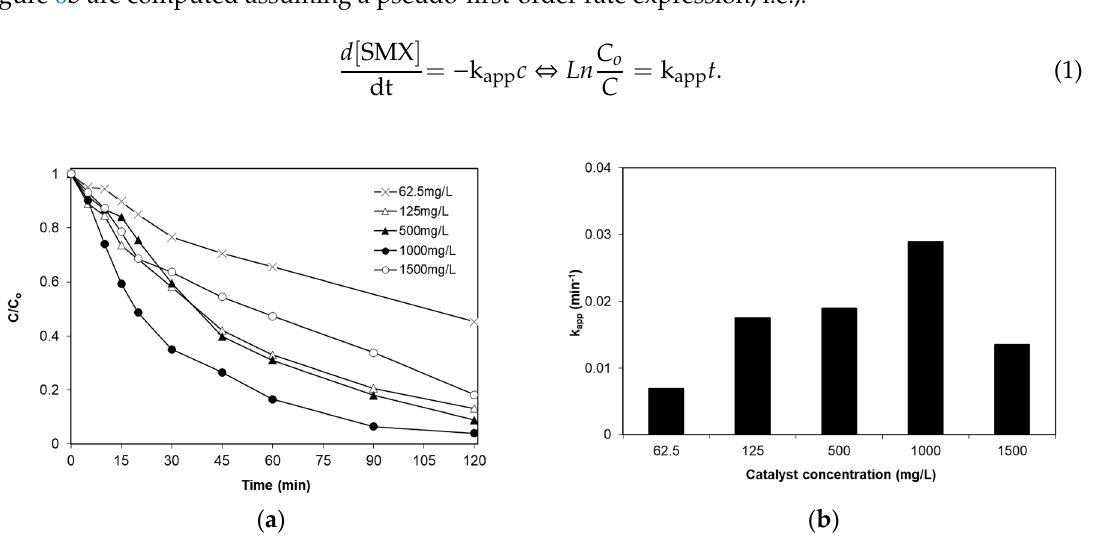
Figure 6. Effect of catalyst loading on the photocatalytic degradation of SMX in UPW ( a ) and apparent kinetic constants ( b ). [SMX] = 234 μ g/L and natural pH.